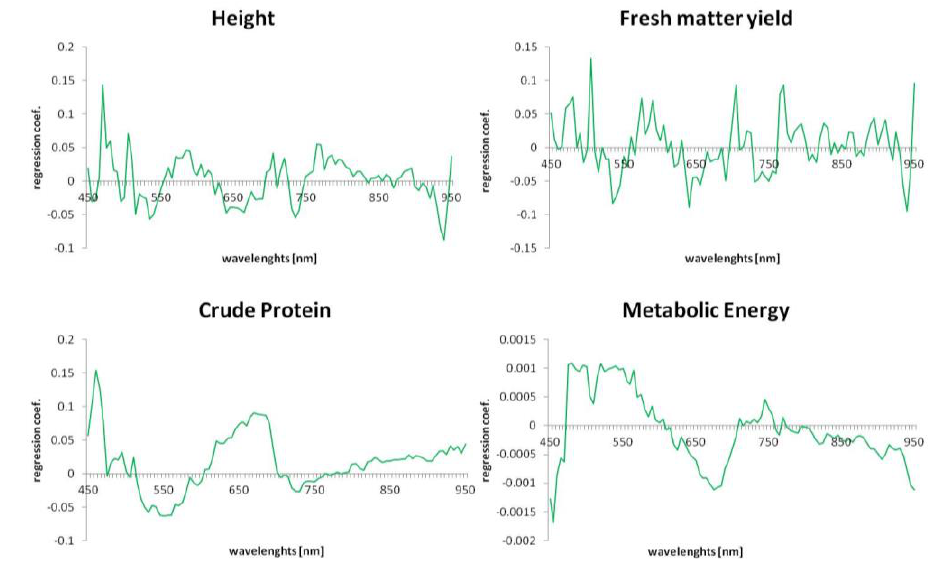
Figure 12. PLSR coefficients for height, fresh matter yield, crude protein, and metabolic energy for the PLSR model of the integrated dataset of May and October, including both organic and inorganic fertilization